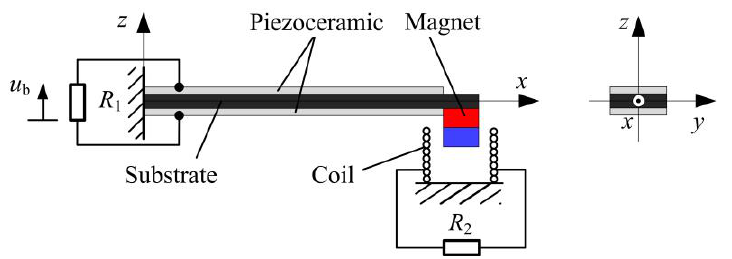
Figure 1. Schematic diagram of the hybrid energy harvester.